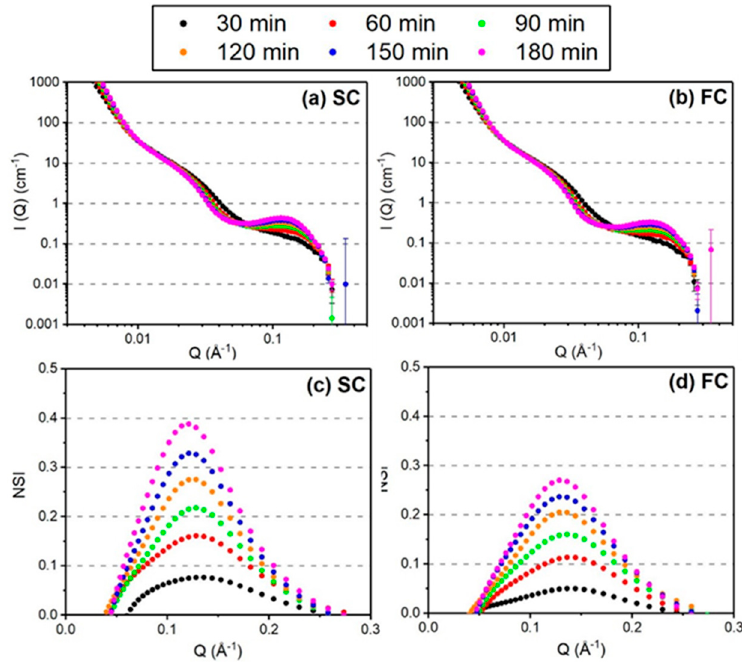
Figure 4. SANS intensity ( a , b ) and NSI ( c , d ) of SDSS 2507 aged in situ at 475 °C. Table 4. Spinodal wavelength and phase separation amplitude of the samples aged in situ at 475 °C. Aging